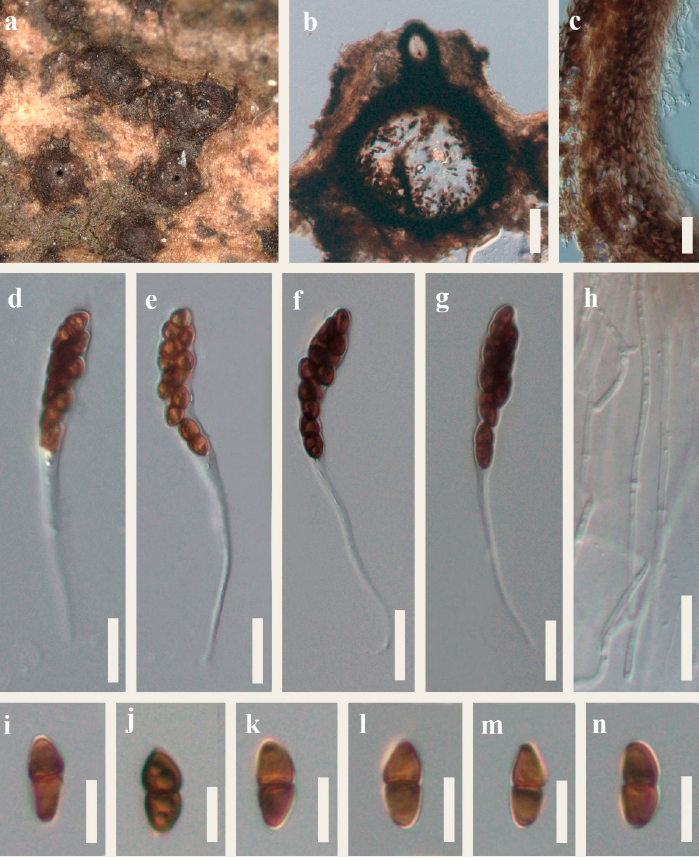
Figure 4. Montagnula donacina (HKAS 124552). ( a ) Appearance of ascomata on the substrate, ( b ) Section through ascomata, ( c ) Peridium, ( h ) Paraphyses, ( d – j ) Asci, ( i – n ) Ascospores. Scale bars: ( b ) = 100 µ m, ( c – h ) = 20 µ m, ( i – n ) = 10 µ Table 3. Morphological comparison of M. donacina and M. chromolaenicola , M. puerensis , M. saikhuen- sis , and M. thailandica .